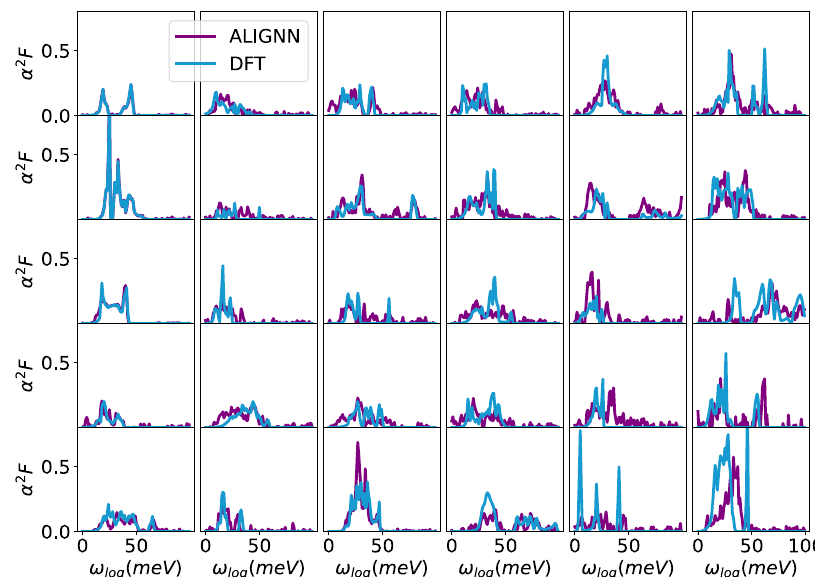
Fig. 7 Prediction of Eliashberg function with ALIGNN for the 5% test set. ALIGNN can capture peak-positions and heights reasonably